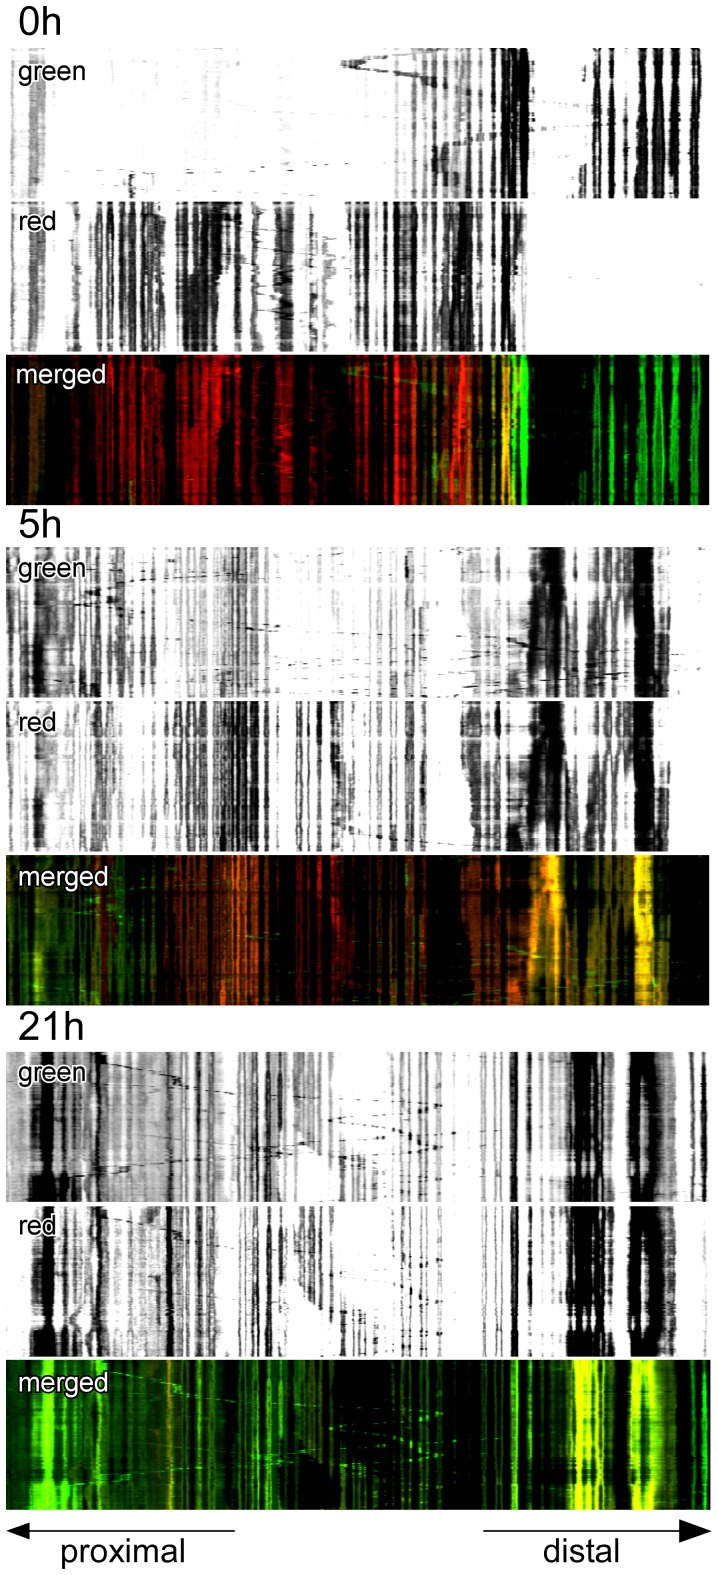
Slow fusion and rapid movement of mitochondria within the same neurite.Time lapse images were taken every 10 seconds for 30 minutes at 0 h, 5 h, and 21 h following the marking of a subpopulation of mitochondria within a living neurite (56 div). The data are presented as kymographs, and show a progressive fusion of all of the mitochondria under observation with organelles originating from the proximal (cell body) and distal sides of the process. At each time point a limited number of mitochondria move during the time lapse imaging. After 21 hours, moving organelles appear to be the product of fusion events.